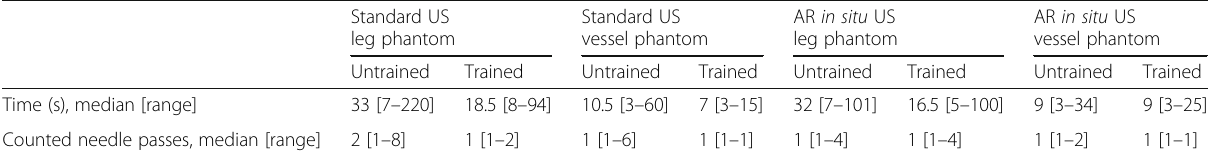
Table 1 Time and counted needle passes using standard ultrasound versus augmented reality in situ ultrasound in the leg phantom and vessel phantom in untrained and trained